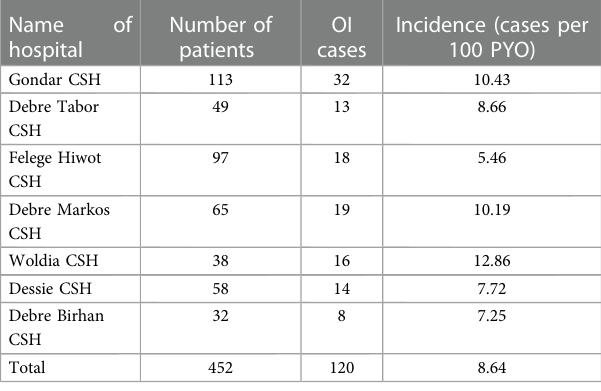
TABLE 4 ART and medication-related characteristics of HIV-infected children receiving ART at Amhara regional state comprehensive specialized hospitals, Ethiopia, 2022 ( n =452).